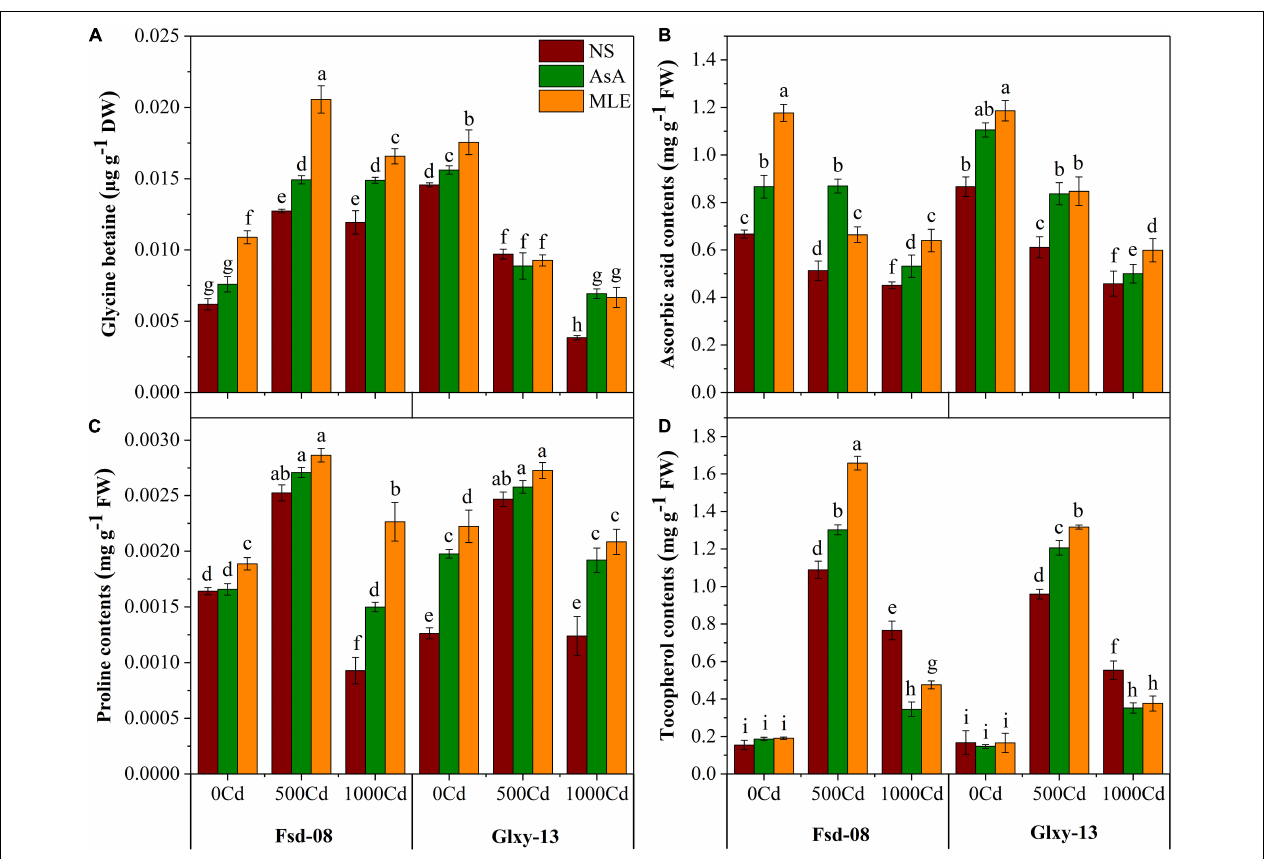
FIGURE 3 | Osmolyte accumulation responses as (A) glycine betaine, (B) AsA, (C) proline contents, and (D) tocopherol contents, under the foliar spray of AsA and MLE, along with NS in two wheat cultivars (Fsd-08 and Glxy-13) exposed to the Cd toxicity. Different lowercase letters denote significant difference as determined by LSD test ( p < 0.05, n = 4). AsA and MLE were applied at the rate of 50 mM and 3% (w/v),